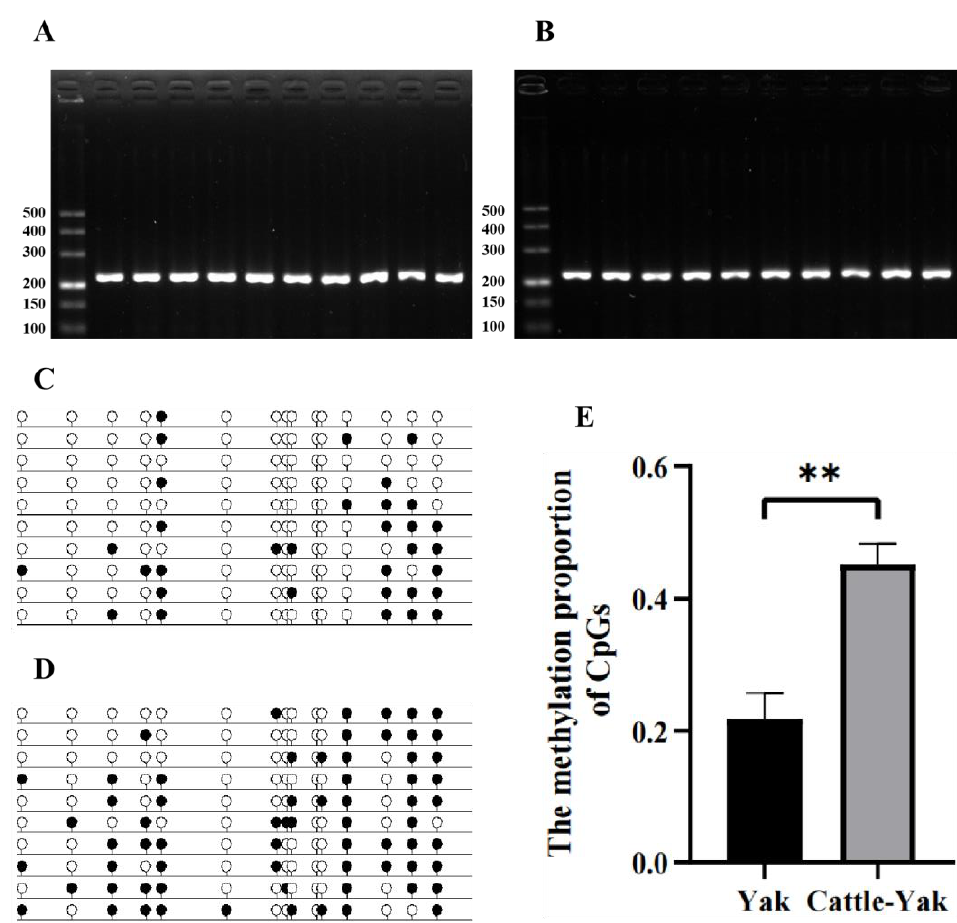
Figure 6. The methylation status of TSSK1B promoter region. ( A , B ) Ten BSP-amplified products of bisulfite-converted DNA sequence selected from TSSK1B promoter region, including the CpG island, in adult yak and cattle–yak testis, respectively. ( C , D ) The methylation status of CpG sites from adult yak and cattle–yak testes drew out with the sequencing results. The black circles represent methylated CpGs, and white circles represent unmethylated CpGs. ( E ) The methylation percentages of CpG sites in adult yak and cattle – yak testis calculated from ( C , D ). ** represents p < 0.01 .